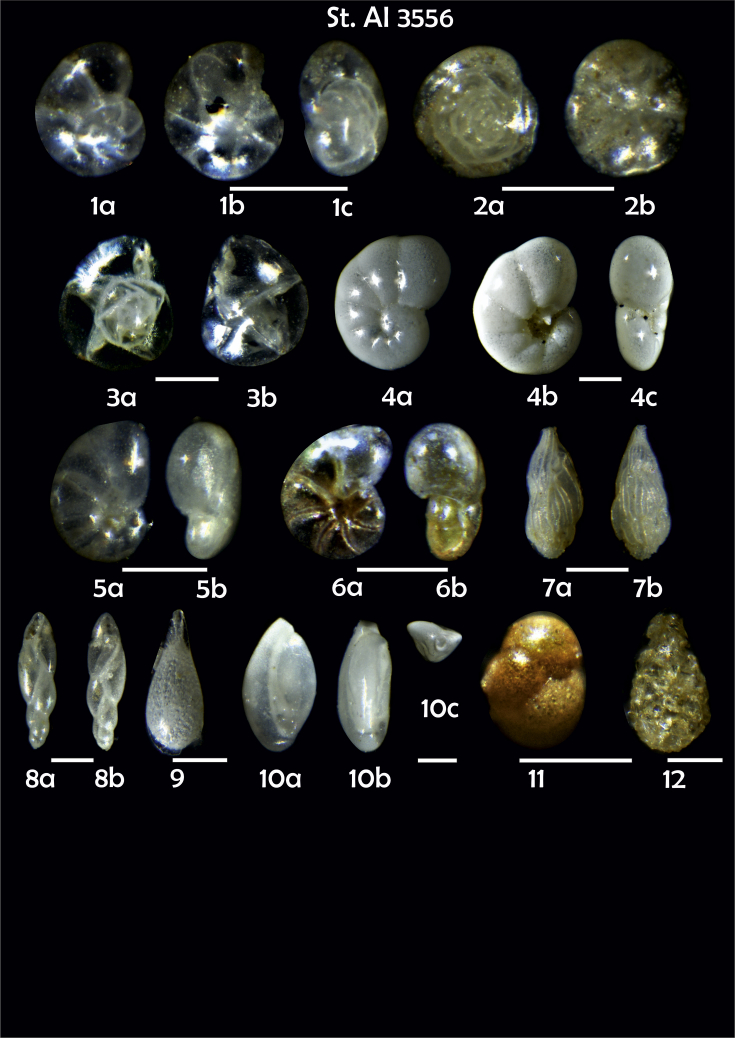
Station 35561 ?, like 3548 (4), a spiral view, b umbilical view, c apertural view. 2Alabaminella weddellensis, a spiral view, b umbilical view. 3Epistominella exigua,a spiral view, b umbilical view. 4Nonionoides grateloupii,a spiral view, b umbilical view, c apertural view. 5Nonionella auricula, a umbilical view, b apertural view. 6Pullenia sp., a lateral view, b apertural view. 7Trifarina angulosa, a, b lateral view. 8Fursenkoina complanata, a apertural view, b lateral view. 9Lagena sp. 10Triloculina trihedra, a, b lateral view, c apertural view. 11Cystammina pauciloculata. 12Lagenammina difflugiformis. Scale 100 μm.